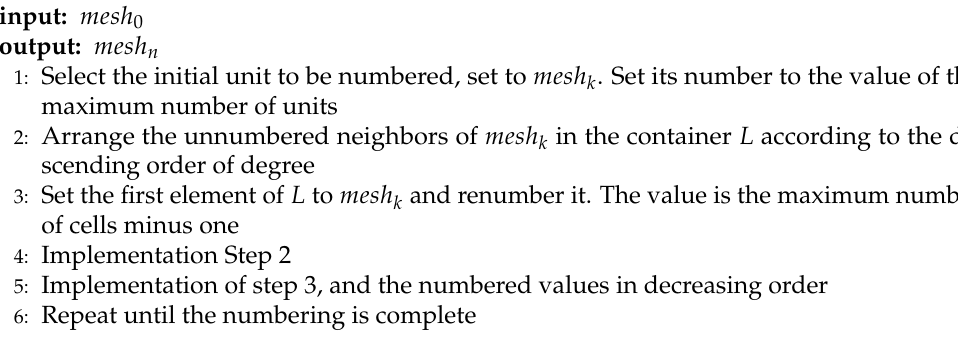
Algorithm 1 RCM numbering